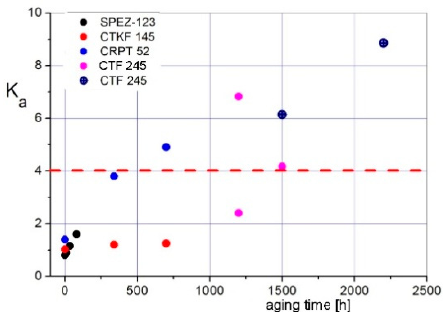
Figure 9. The impact of the aging time on the absorption coefficient K a value calculated for different RBP and RIP-insulated bushings [16].